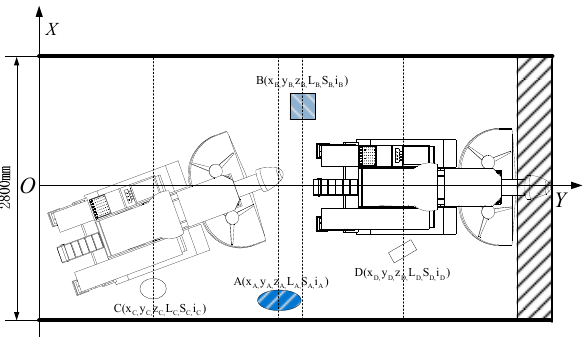
Figure 9. Schematic diagram of roadway environment modeling.